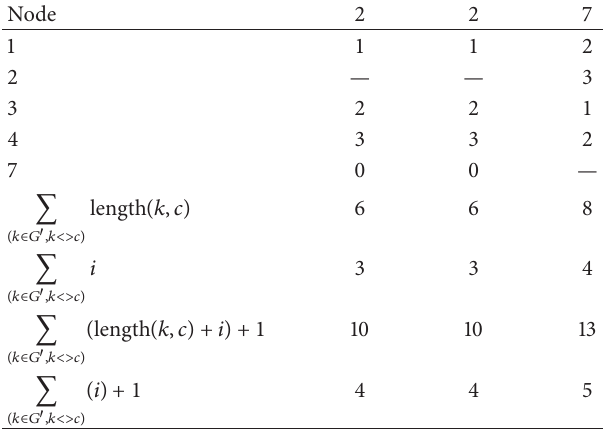
Table 2: Length and number of shortest path reduced in simplifica- tion.